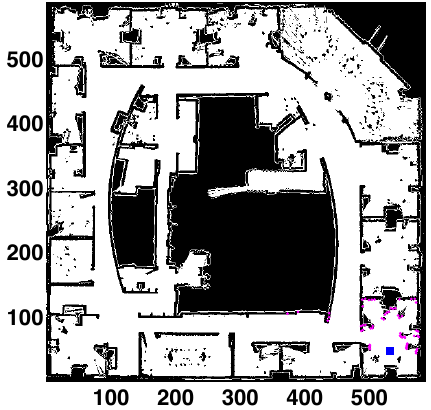
Figure 4. Global localization (GL) in a real map (Intel lab). All units in cells. Laser readings in purple. Robot’s location (531, 48, 85) in blue.